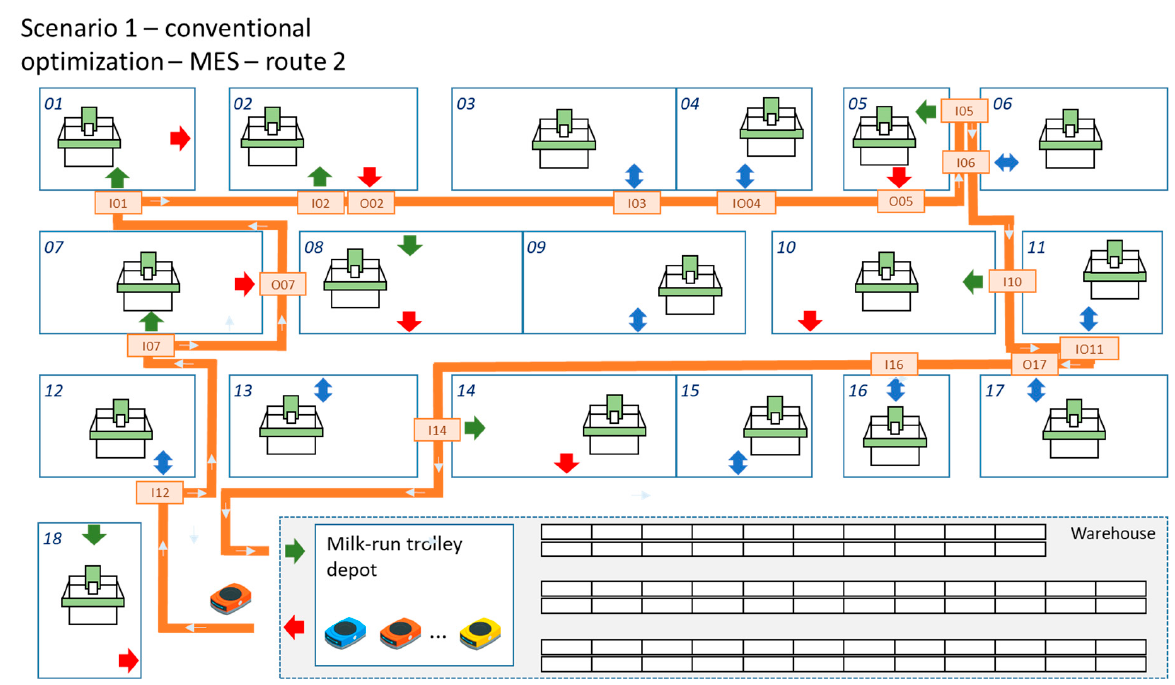
Figure 4. The second route of the conventional milk-run-based in-plant supply including MES data-based supply Table 4. Numerical results of the scheduling of predefined specific in-plant material supply opera- tions performed by the milk-run trolley within route 2.